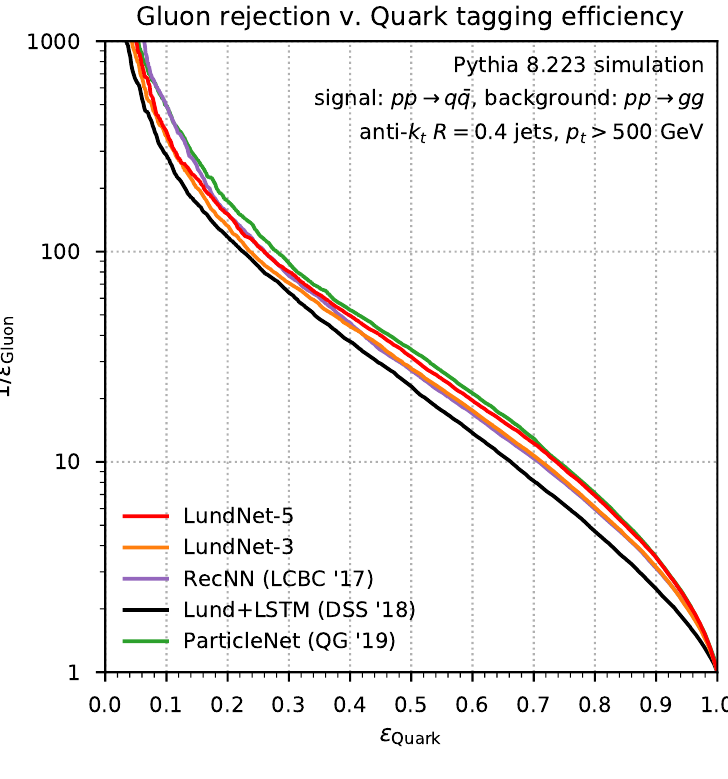
Figure 7 . Background rejection 1 /(cid:15) Gluon versus signal efficiency (cid:15) Quark for quark/gluon discrimi- nation between R = 0 . 4 anti- k